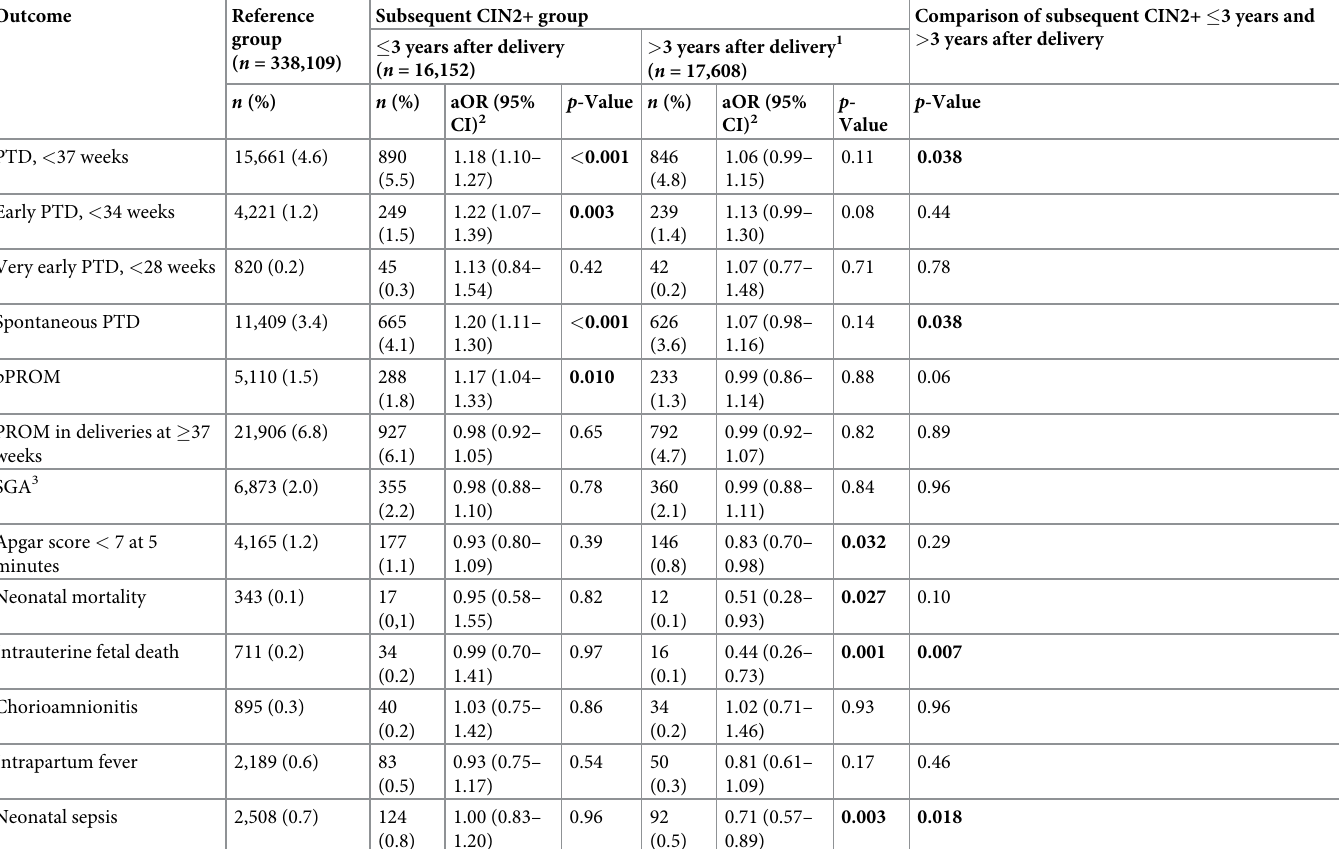
Table 3. Obstetric and neonatal outcomes in the subsequent CIN2+ group compared with the reference group, stratified for interval from delivery to CIN2+ diagno- sis—adjusted multivariable logistic regression analyses.